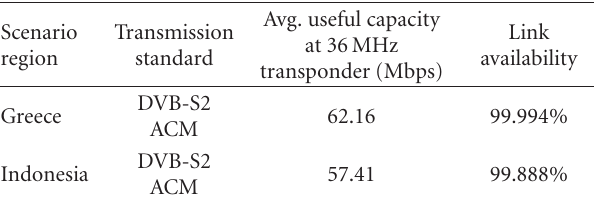
Table 5: Broadcasting with DVB-S2 ACM in the two Scenarios—